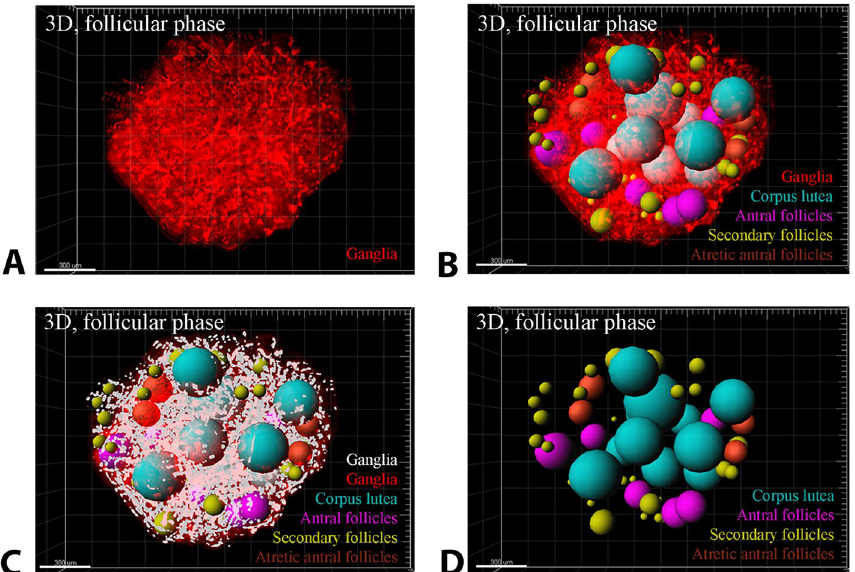
Figure 2. Three-dimensional (3D) reconstruction and segmentation of mice ovary structures after Golgi–Cox staining for detection of ovarian structures relationship with ganglia networks. ( A ) Whole tissue imaging and 3D reconstruction of mice ovary after Golgi–Cox staining (red color represent the ganglia); ( B ) ovarian follicles and corpora lutea segmentations in the whole tissue 3D reconstructed ovary. The blue spots represent Antral follicles, yellow spots represent secondary follicles, purple spots represent corpus luteum and brown spots represent atretic antral follicles. ( C ) Ovarian follicles, corpora lutea and ganglia segmentations. Ganglia are shown with white cells. ( D ) Ovarian follicles and corpora lutea segmentations. All scale bars in four images are 300 µm. All images are processed and drawn by Imaris